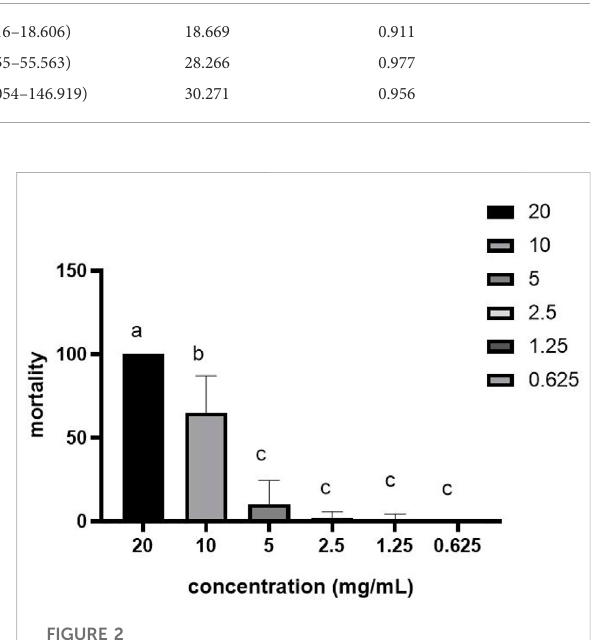
FIGURE 2 The mortality of benzoic acid-2-benzyloxy-3,4- tetrahydrofuran diester against S.scabiei at60 min.The difference between data with the different small letters within a column is signi fi cant ( p <